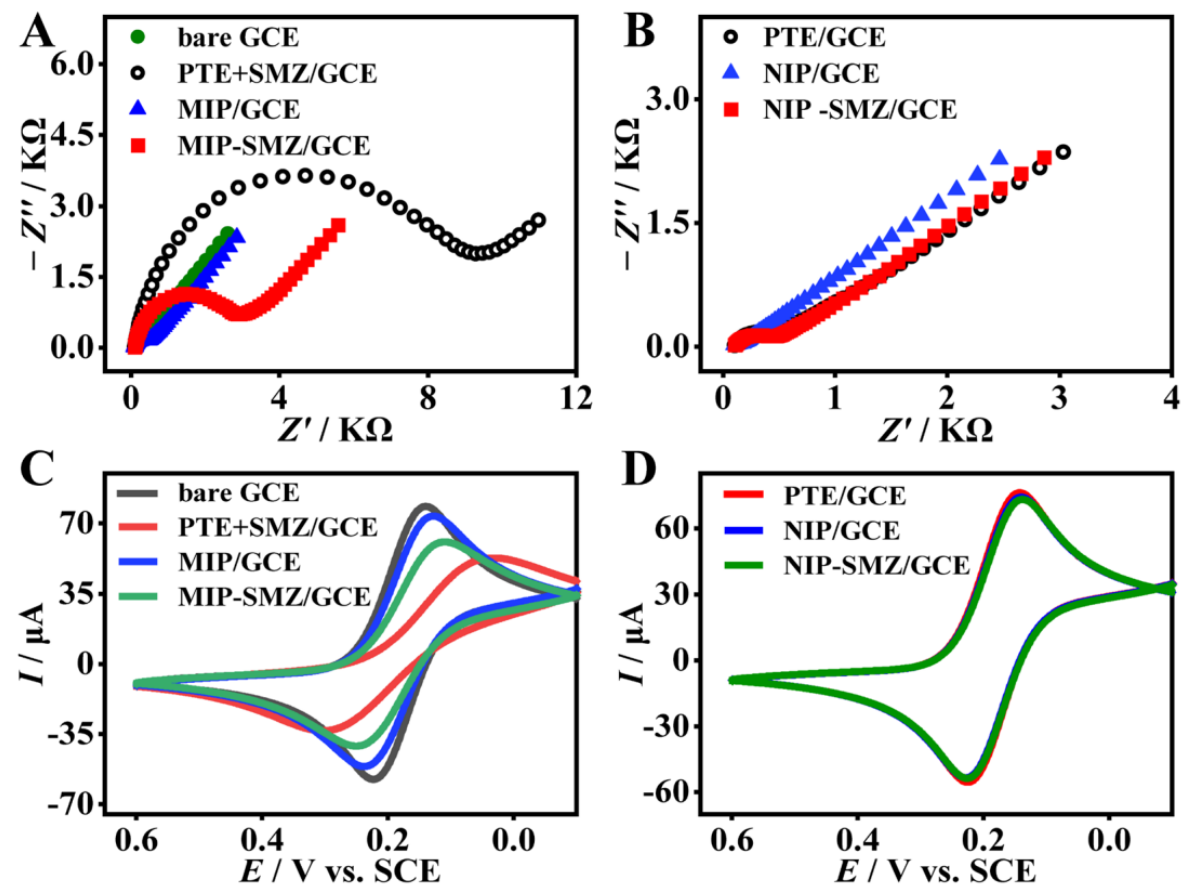
Figure 3. Electrochemical characterization for the fabrication process of the MIP film. ( A , B ) EIS and ( C , D ) CV curves for different modified glass carbon electrode (GCE).